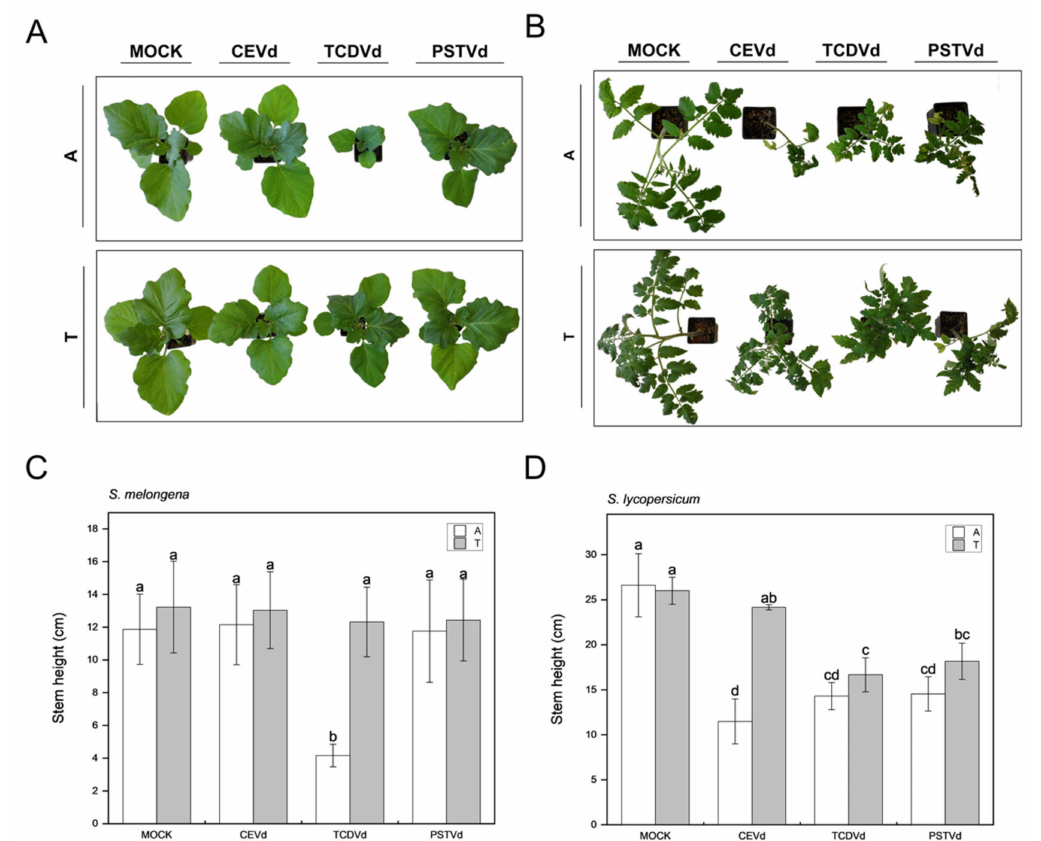
Figure 2. Symptomatology caused by CEVd, TCDVd, and PSTVd by agro- and transcript-inoculations in eggplant and tomato. Representative images of Solanum melongena cv Black Beauty ( A ) and Solanum lycopersicum cv Rutgers ( B ) of mock and viroid-inoculated plants using agro-inoculation (upper images; A) and transcript (lower images; T). ( C ) Quantitation of mean leaf size in agro- and transcript-inoculated eggplant plants. ( D ) Quantitation of stem height in agro- and transcript- inoculated tomato plants. Data correspond to the mean plants ± SD of at least three independent replicates. Data were analyzed using a Mann–Whitney test and different letters indicate significant differences ( p ≤